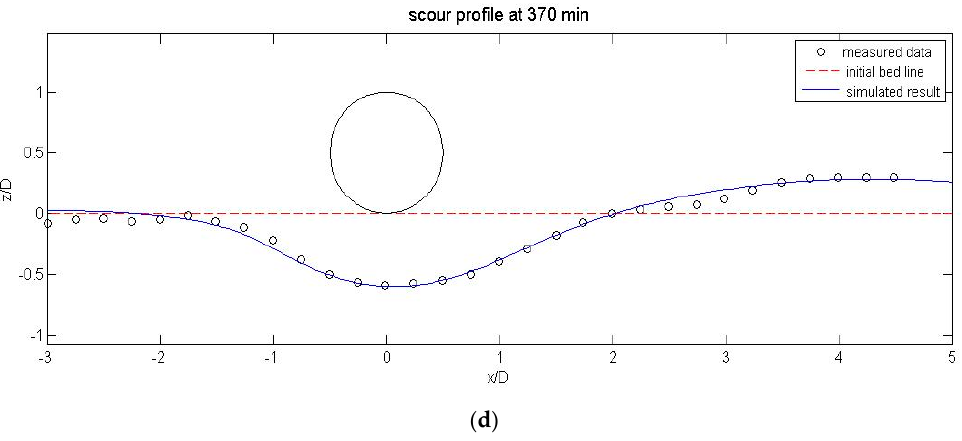
Figure 9. The scour profile at different times, ( a ) T = 10 min; ( b ) T = 30 min; ( c ) T = 200 min; ( d ) T = 370 min. The velocity vector and scour profiles at 0.1 min, 0.5 min, 1 min and 5 min are abstracted to study